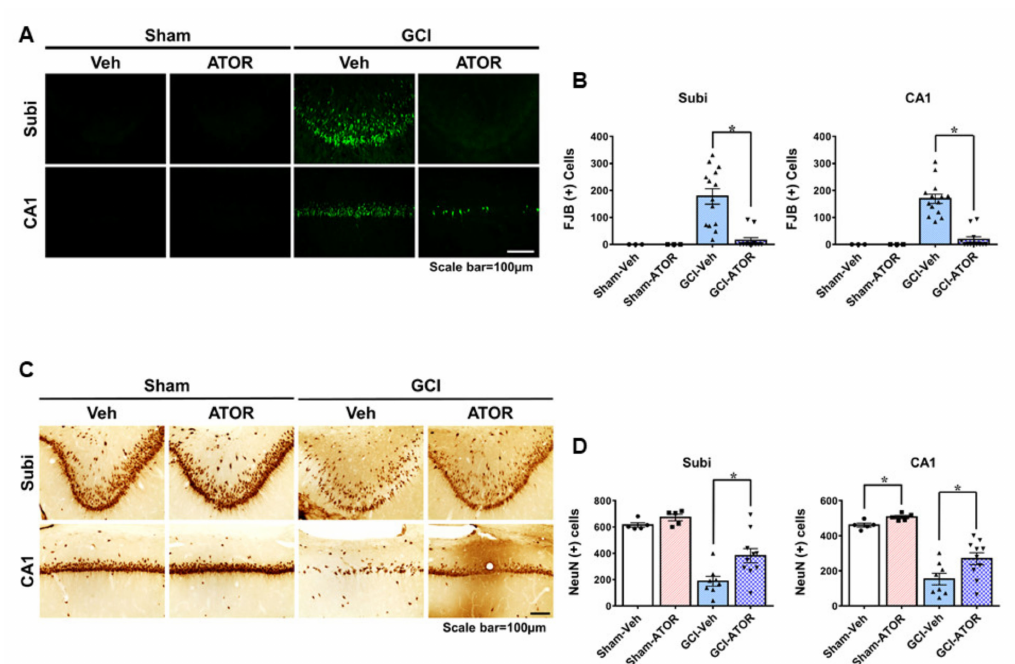
Figure 1. Atorvastatin reduces neuronal death after global cerebral ischemia. Global ischemia induced neuronal death in the subiculum and CA1 of the hippocampus region 1 and 4 weeks after ischemia. Fluoro-Jade B-positive neurons in Subi and CA1 ( A ). Oral post-treatment with atorvastatin (5 mg/kg) for 1 week demonstrated neuroprotective effects after ischemia. Live neurons in Subi and CA1 ( C ). Oral post-treatment with atorvastatin (5 mg/kg) for 4 weeks demonstrated neuroprotective effects after ischemia. Atorvastatin greatly decreased hippocampal neuronal death compared with the vehicle treatment. Scatter dot plot bar graphs represent the quantified degenerating and live neurons ( B , D ). Data are the mean ± S.E.M.; for the acute model, n = 3 for each sham group. n = 12–14 for each ischemia group. For the chronic model, n = 5 for each sham group, n = 8–10 for each ischemia group. * Significantly different from the vehicle-treated group, * p <